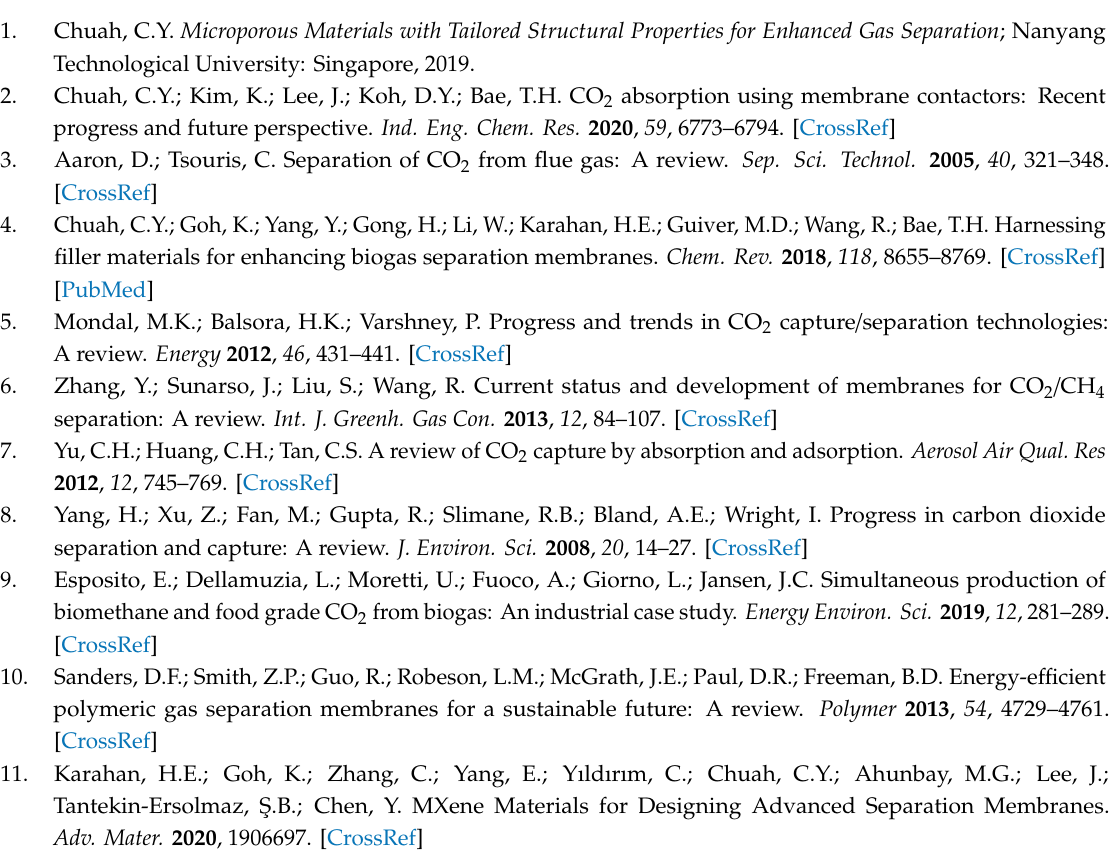
Figure S1: EDX analysis of UiO-66-Br, Figure S2: ( a ) CO 2 adsorption at 25 ◦ C; ( b ) N 2 adsorption at 25 ◦ C; ( c ) Isosteric heat of adsorption of CO 2 and ( d ) CO 2 / N 2 IAST selectivity (feed mixture of CO 2 / N 2 = 20 / 80) for UiO-66, UiO-66-NH 2 , UiO-66-Br and UiO-66-(OH) 2 , Figure S3: FTIR spectrum of mixed-matrix membrane, Figure S4: XRD analysis of mixed-matrix membrane, Figure S5: TGA analysis of mixed-matrix membrane, Figure S6: Comparison of the gas permeation data with the upper bound limit for CO 2 / N 2 constructed in 2008. The numerical number indicated in the figure illustrate the value of F index as described in Section 2.4.5. The data used in this plot is provided in Table 4, Table S1: Elemental analysis of UiO-66 and its derivative, Table S2: Theoretical amount of UiO-66 and its derivative, Table S3: Fitting parameters for CO 2 and N 2 for UiO-66 and its derivative at 25 ◦ C, Table S4: Fitting parameters for CO 2 and N 2 for UiO-66 and its derivative at 35 ◦ C, Table S5: Fitting parameters for CO 2 and N 2 for polymeric and mixed-matrix membranes at 35 ◦